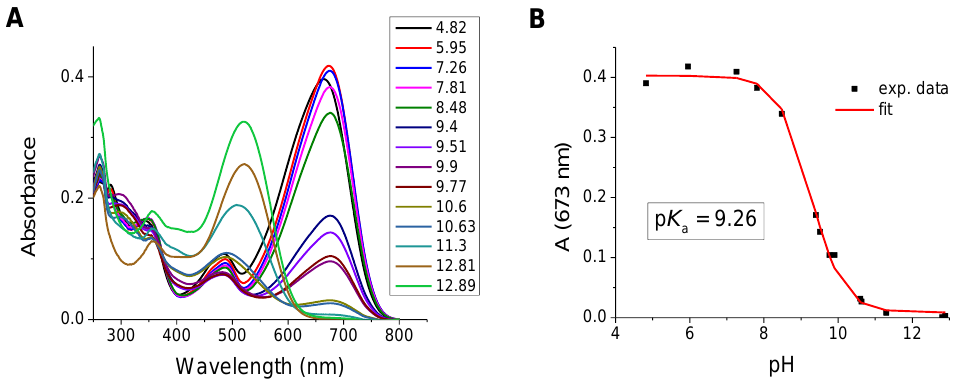
Figure 3. ( A ) UV-Vis absorption spectra of 1 in neutral to basic conditions (4.8 < pH < 12.9); ( B ) experimental data points collected at 673 nm, with corresponding fit for the pH equilibrium. Experimental conditions: [ 1 ] = 1.7 × 10 −5 M, in MeOH:Theorell and Stenhagen universal buffer:H 2 O 50:25:25.